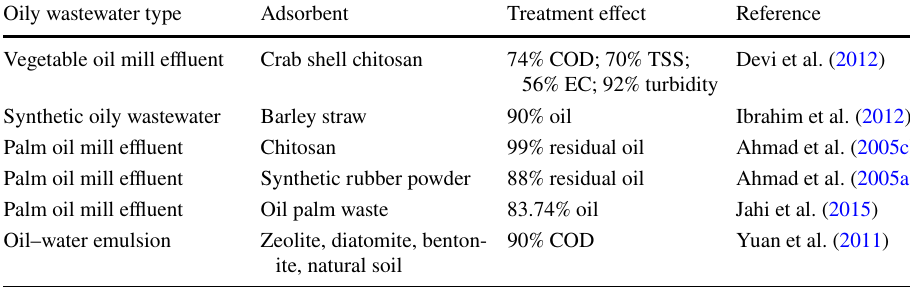
Table 5 Efficiencies of adsorption method in the removal of pollutants from oily